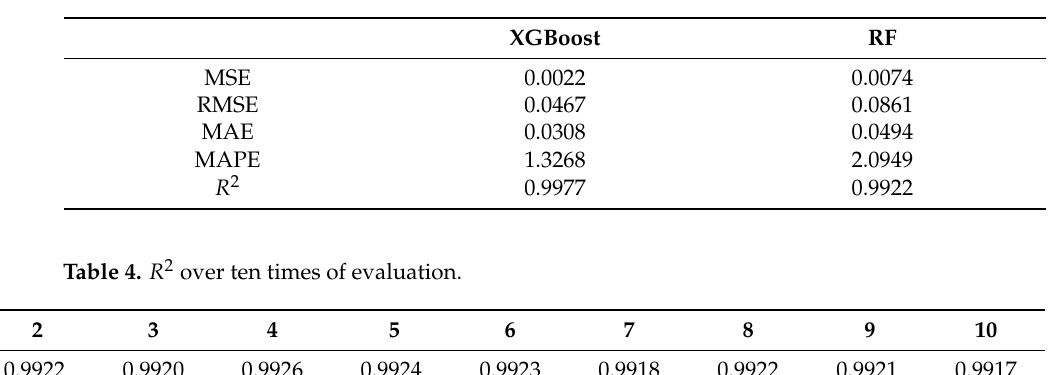
Table 3. Ten times average evaluation results.